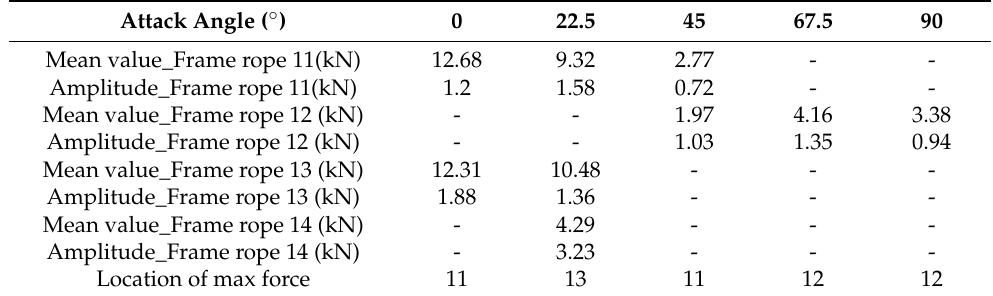
Table 8. Mean values and amplitudes of the mooring forces on frame ropes under different attack angles.